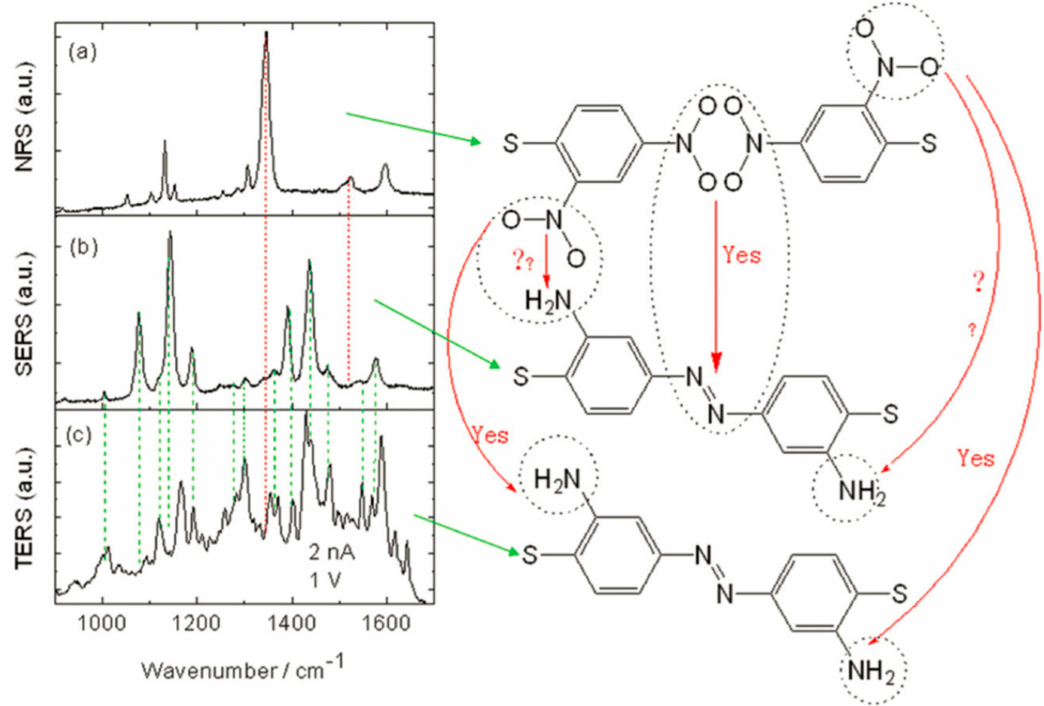
Figure 2. ( a ) Normal Raman scattering (NRS) of 2,4-DNBT power, ( b ) and ( c ) SERS and TER spectra of 2,4-DNBT